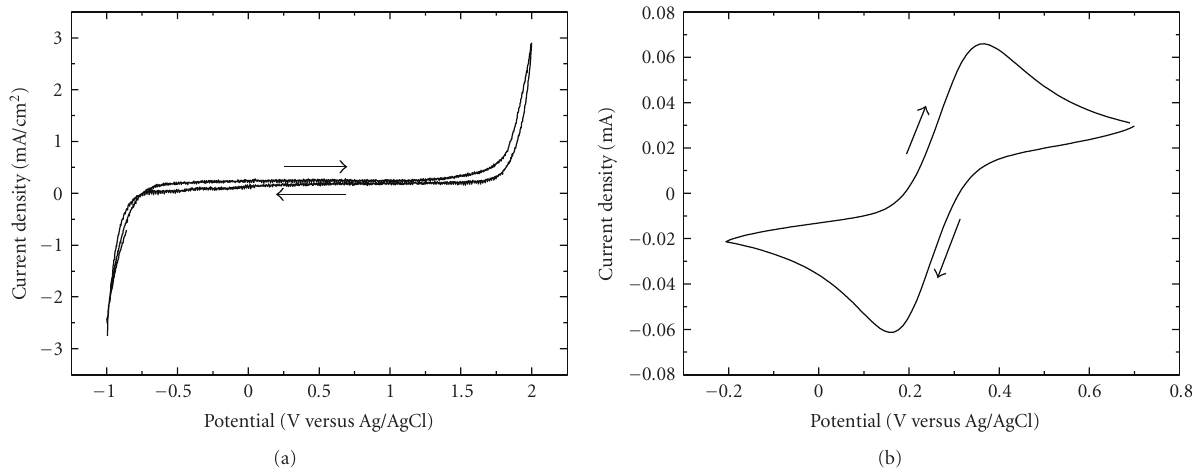
Figure 5: CV i - E curves for undoped NCD electrode in (a) 0.5 molL − 1 H 2 SO 4 (0.1V.s − 1 ) and (b) 1mmolL − 1 ferrocyanide/0.1 molL − 1 KCl (10mV.s − 1 ), respectively.